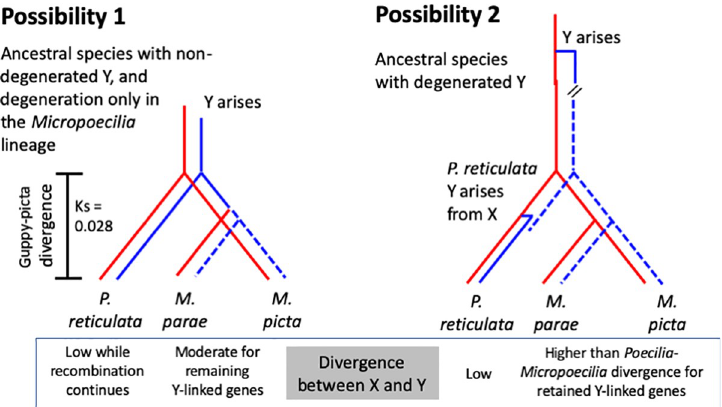
Fig 1. The two possible evolutionary histories of the guppy and Micropoecilia Y chromosomes. The diagrams show the possibilities for the ancestry of the two Micropoecilia species whose Y chromosomes have degenerated (symbolized by dashed blue lines), and the split of the Poecilia and Micropoecilia lineages. The expected differences that might allow the two possibilities to be distinguished are shown below the diagrams (see text for